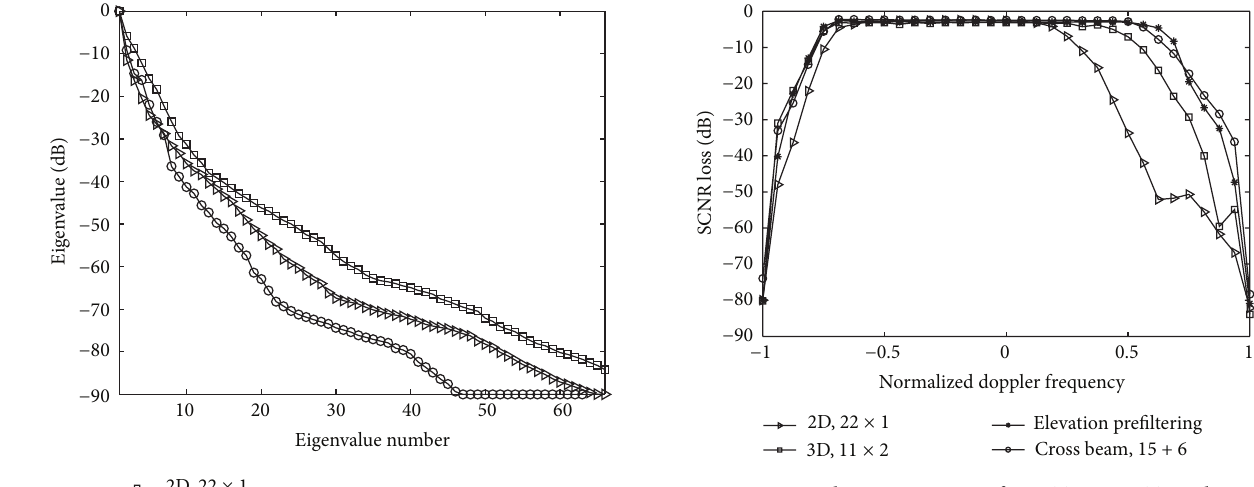
Figure 7: SCNR loss comparison of 2D STAP, 3D STAP, elevation prefiltering STAP, and cross beam STAP (no errors).